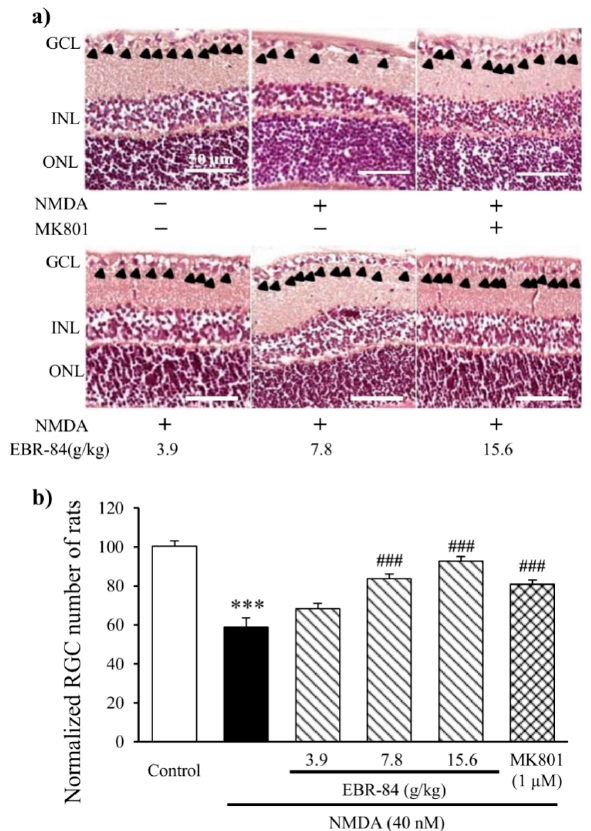
Figure 1. The HPLC fingerprint analysis of the extract from the herbal medicinal compositus prescribed and its main components. The compounds were: Salvianic acid A sodium (1), Salvianolic acid (2), Quercetin-7- O -beta-glucoside (3), Rutin (4), Isorhamnetin-3- O -beta-glucoside (5), Luteolin (6), Epimedium glucoside (7), and Tanshinone 2A (8).